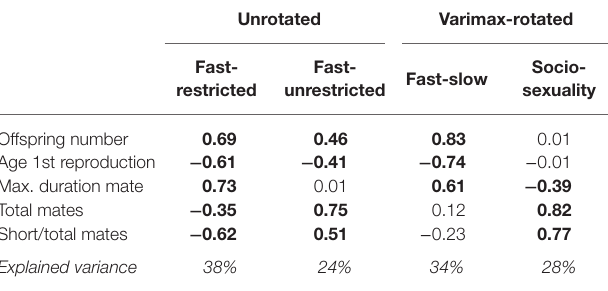
TABLE 2 | Unrotated and varimax-rotated two-component solutions for reproductive LH traits. Unrotated